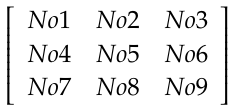
Figure 4. Design of sensing electrodes: ( a ) Division of hand region; ( b ) Arrangement of sensing